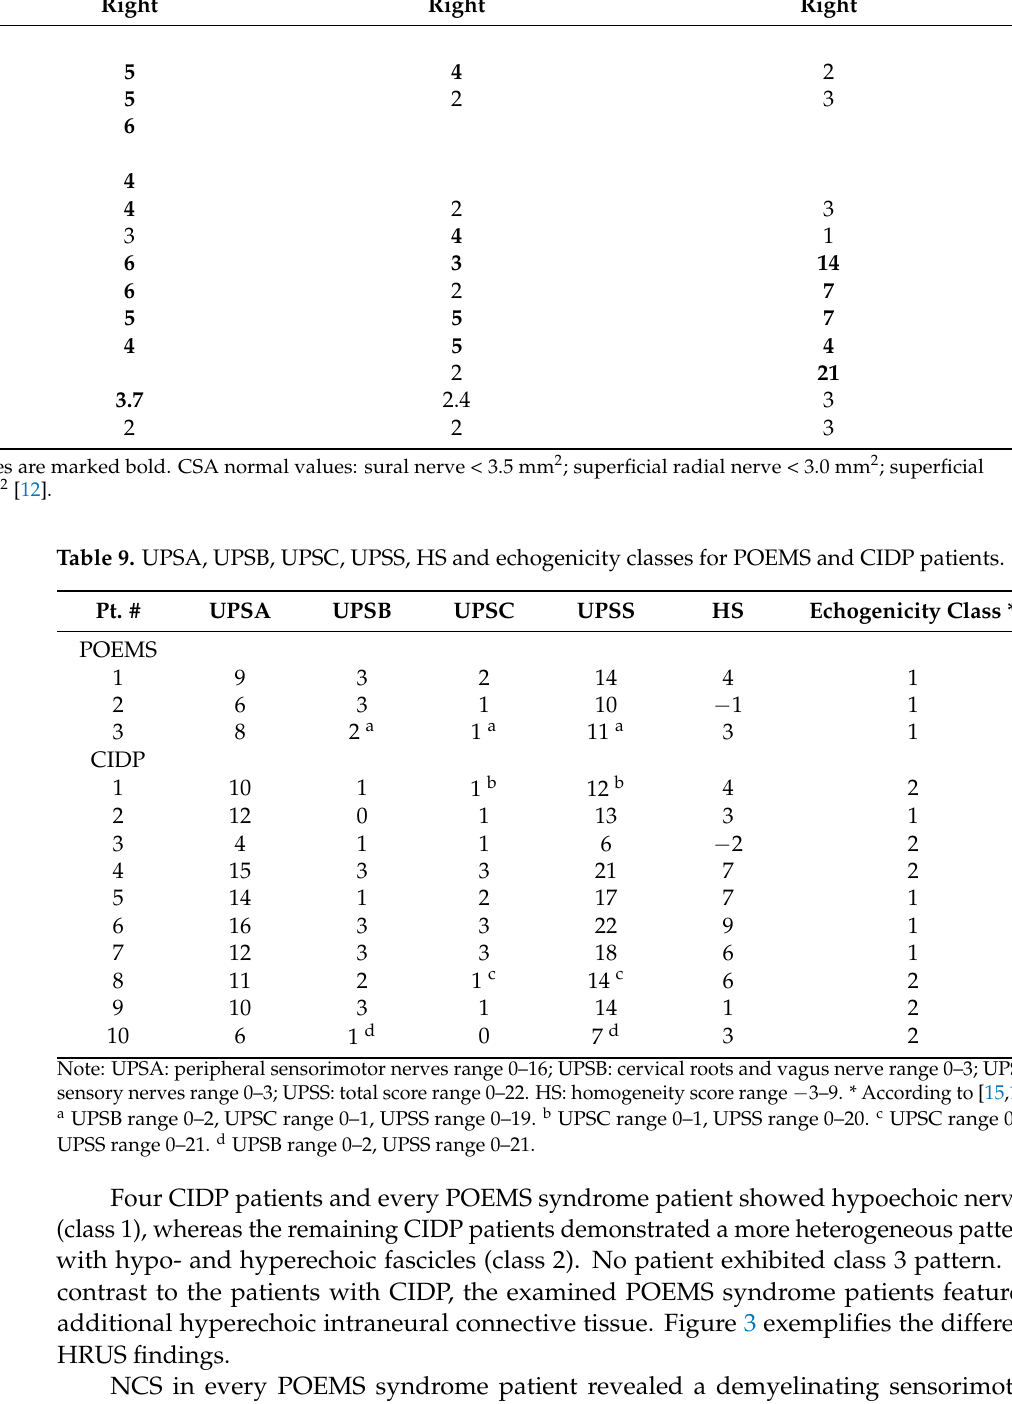
Table 8. HRUS findings in sensory nerves: sural, superf. radial and superf. peroneal nerves in mm 2 . CSA of Sural Nerve CSA of Superf. Radial Nerve CSA of Superf. Peroneal Nerve Pt. # Right Right Right